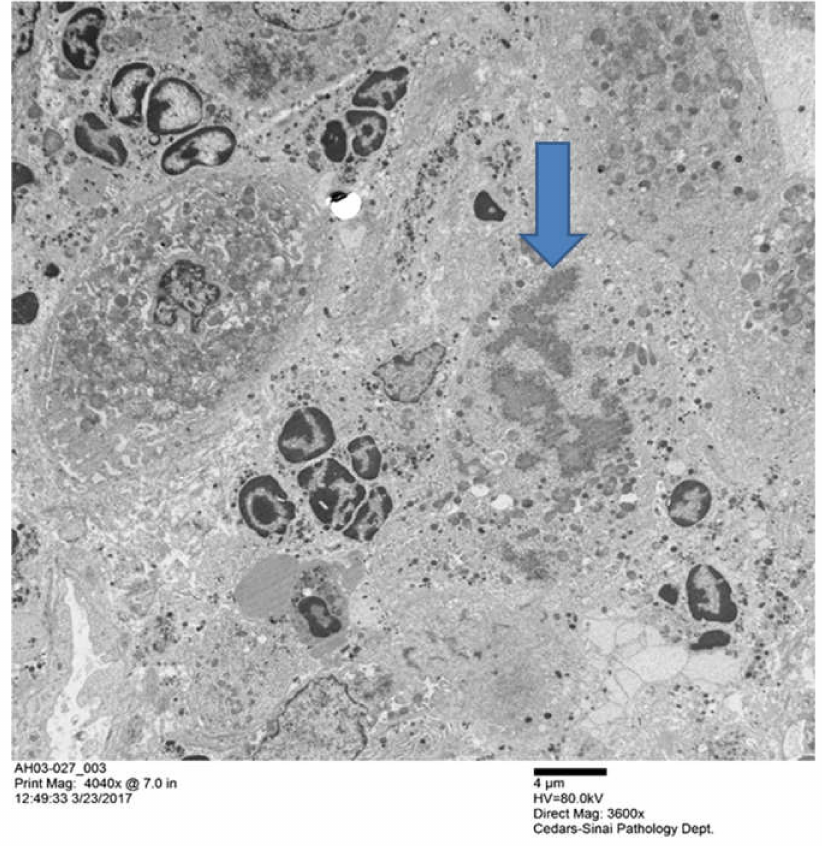
Figure 2. Groups of polymorpho neutrophils (PMN)s with condensed chromatin nuclei, clustered around two hepatocytes that had formed MDBs. The arrow pointed the MDB the MDB ( ×